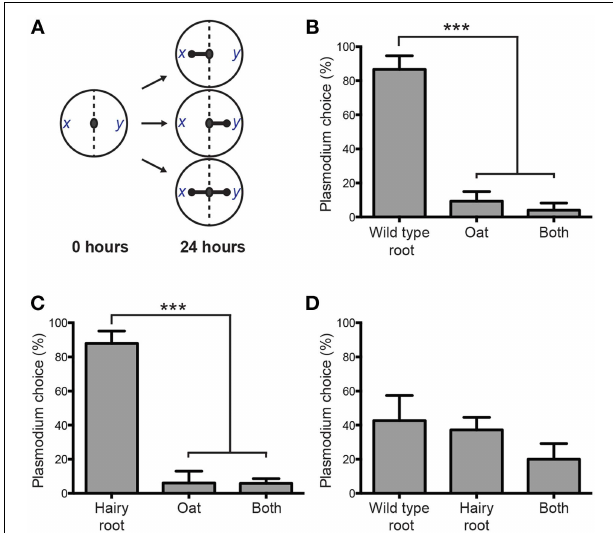
FIGURE 3 | Plasmodium binary choice chemotaxis assay of V. officinalis root tissues. (A) Schematic of the experimental design for the binary choice assay. Locations of two samples are denoted by x and y . Preference for a sample is indicated by a rounded arrow and scored as a positive chemotactic event. Three outcomes are defined: propagation occurs toward sample x , propagation occurs toward sample y , or plasmodium is attracted to both x and y simultaneously. (B) P. polycephalum is strongly attracted to wild type root of the intact V. officinalis plant when copresented with oat, its primary nutrient source. (C) VoHR5 hairy root recapitulates the chemoattractive force of the wild type plant root when co-presented with oat. (D) Plasmodium choice between V. officinalis wild type plant root and Agrobacterium -derived hairy root was not significantly different. Data represent the means ± SD of three independent experiments containing at least twenty replicates each ( *** P ≤ 0 .001, One-Way ANOVA with Tukey’s post-test with a 95% confidence interval. Detailed statistical information is provided in Table S1).